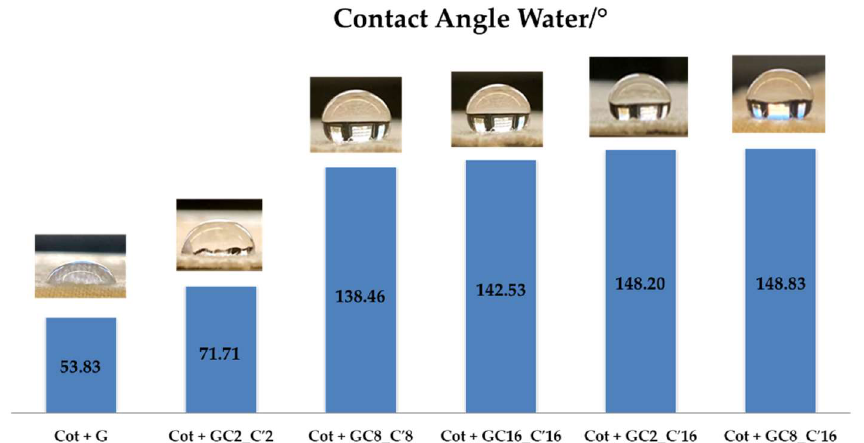
Figure 8. Histograms of the contact angle θw of the cotton fabrics treated by the nanocomposite sol samples G, GC2_C′2, GC8_C′8, GC16_C′16, GC2_C′16, and GC8_C′16 with photos of the representative drops.